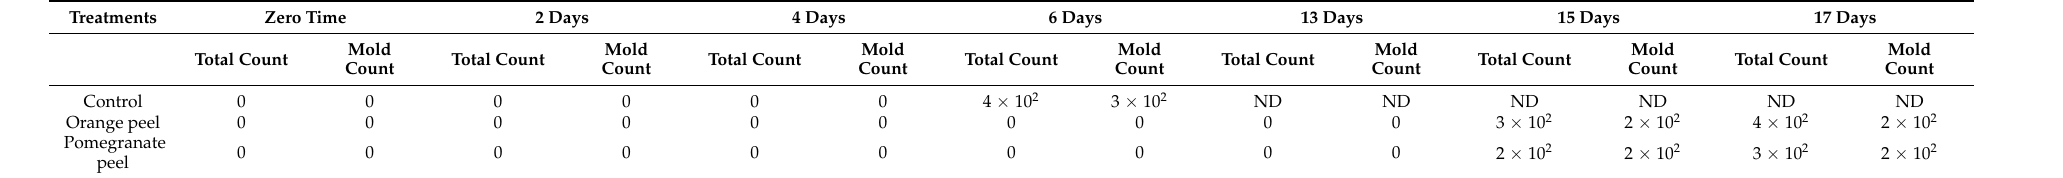
Table 14. Antimicrobial effect of orange and pomegranate peel on storage cake samples at refrigerator temperatures (cfu/g).